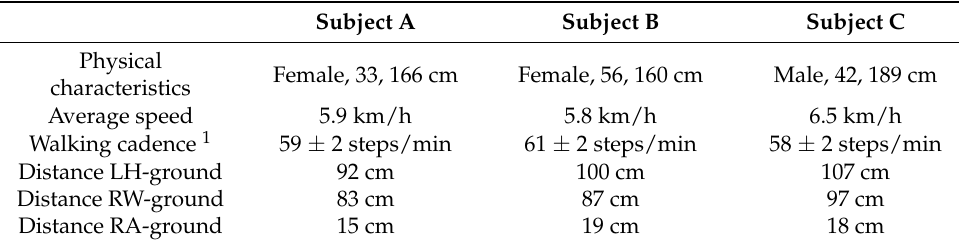
Table 2. Characteristics and parameters of the three subjects in the walking